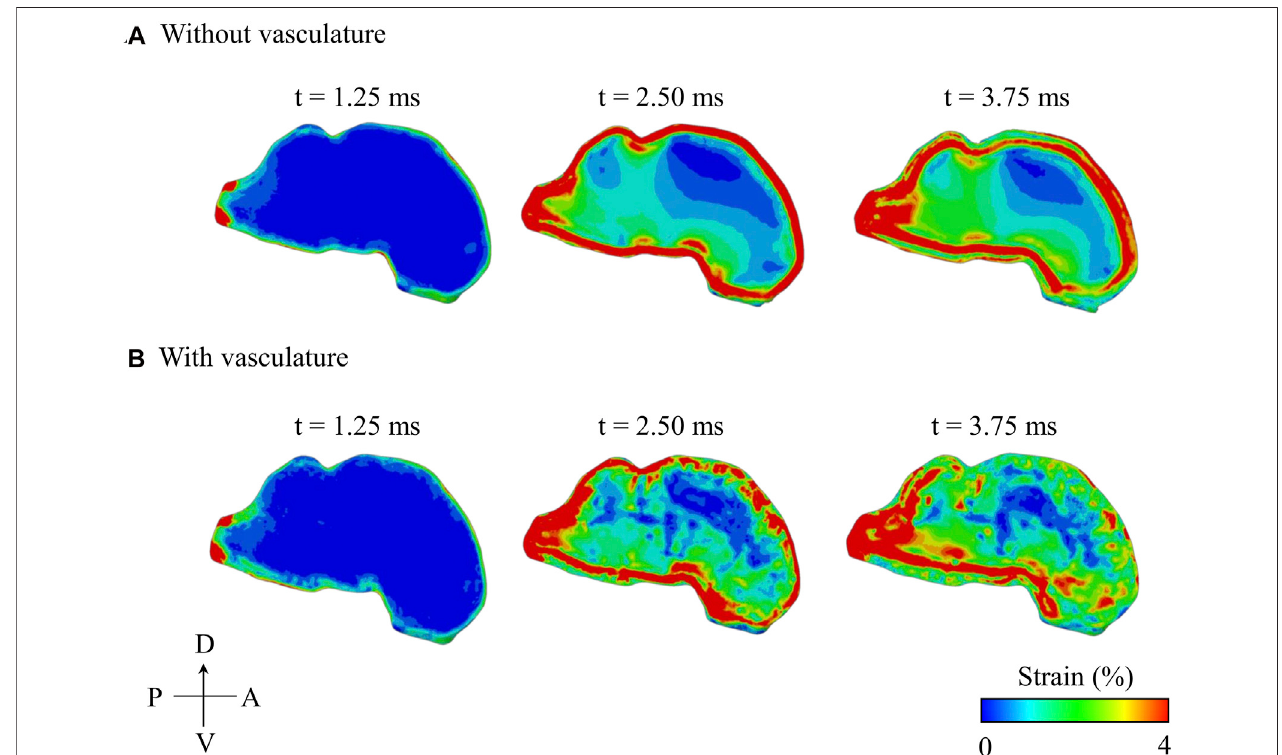
FIGURE8| Comparison ofthepredictedtemporalandspatialpropagationofmaximumprincipalstrainalongthemid-sagittal planeoftheminipighead (A) without vasculature and (B) with vasculature. A: anterior; D: dorsal; P: posterior; V: ventral.